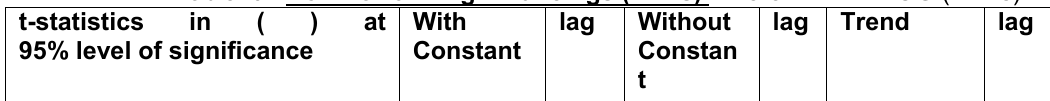
Table: 01 Non-Performing Financings (NPFs) Where LnNPF=LOG